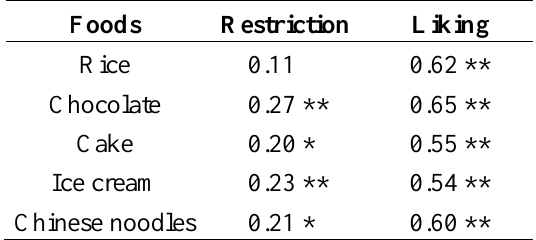
Table 4. Correlations between craving and restriction and between craving and liking for the five items with the highest mean craving